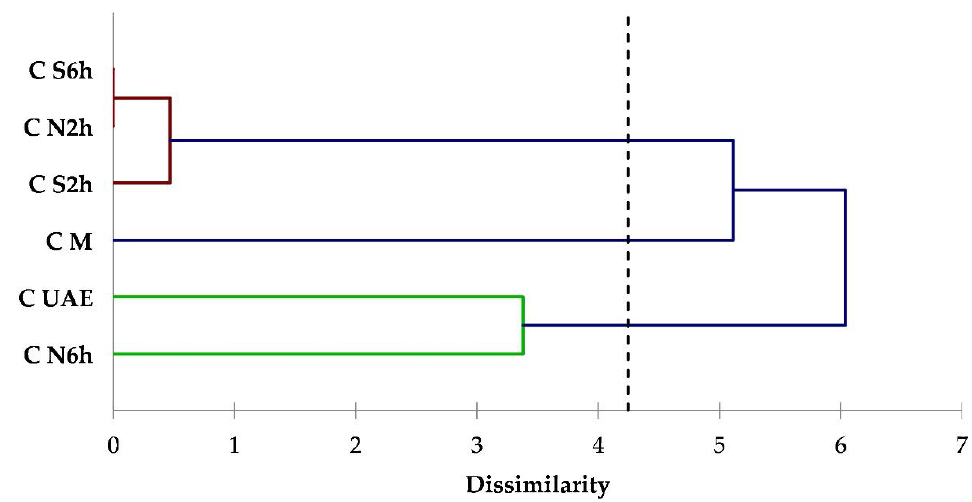
Figure 2. Dendrogram obtained from the cluster analysis based on terpenes classes data for coriander seeds extracts.